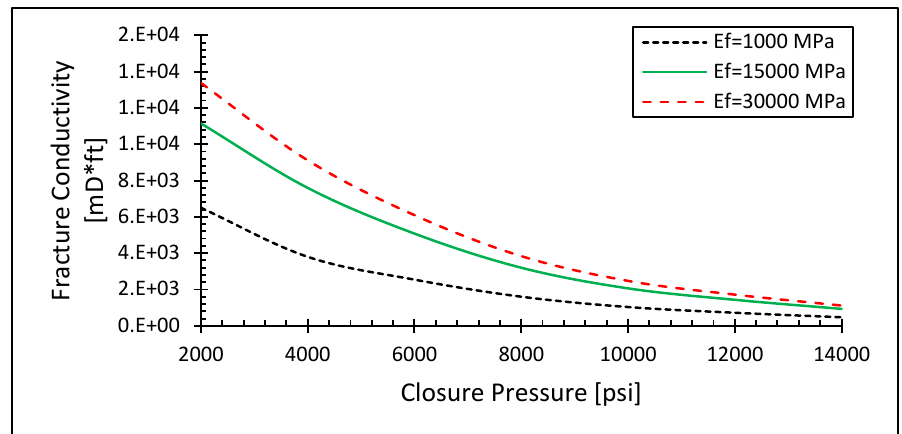
Figure 18. Fracture conductivity for different formation Young ’ s modulus.